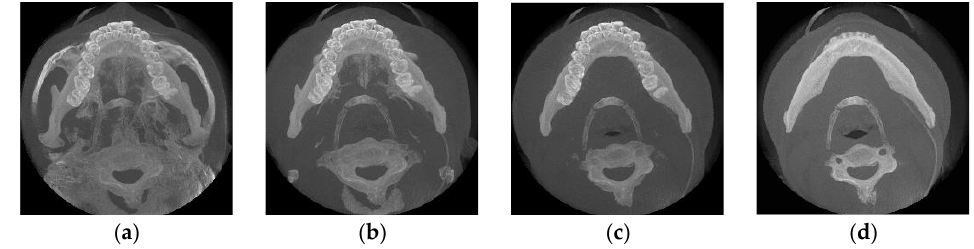
Figure 2. MIP image generation using different data ranges. ( a ) Complete original CBCT data. ( b ) Coronal MIP includes the upper and lower jaw. ( c ) Coronal MIP of mandible. ( d ) Coronal MIP in which the mandible does not contain a crown.